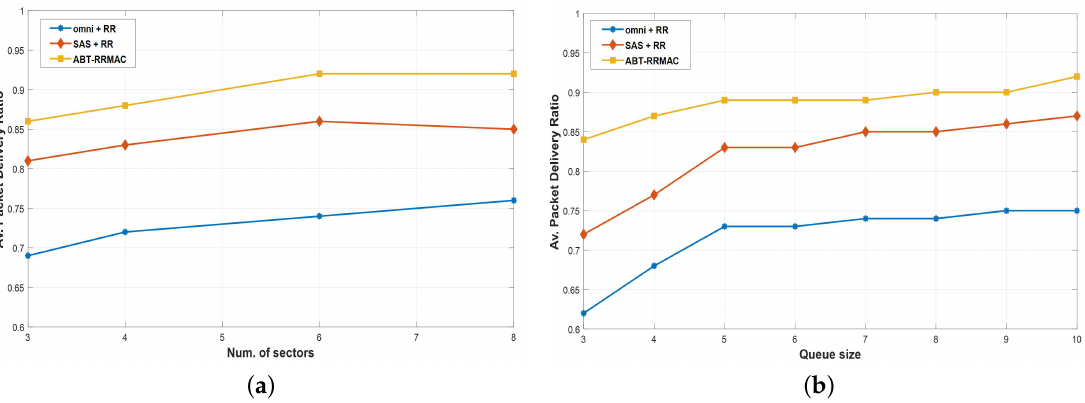
Figure 10. Packet delivery ratio (PDR) comparison. ( a ) Average PDR vs. number of sectors. ( b ) Average PDR vs. queue